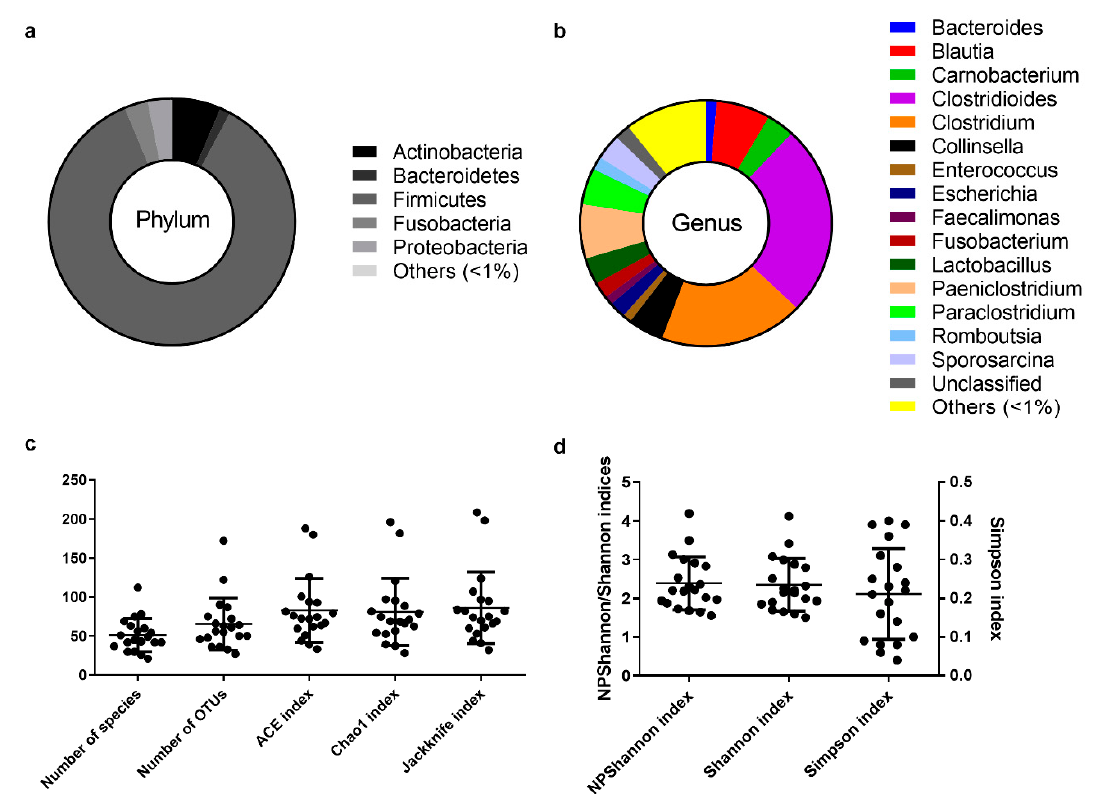
Figure 1. The core intestinal bacterial microbiota of the Egyptian mongoose population. ( a ) Relative abundance on a phylum and ( b ) genus level. ( c ) Species richness (number of species, number of OTUs, ACE, Chao1, and Jackknife indices) and ( d ) species evenness (NPShannon, Shannon, and Simpson indices).